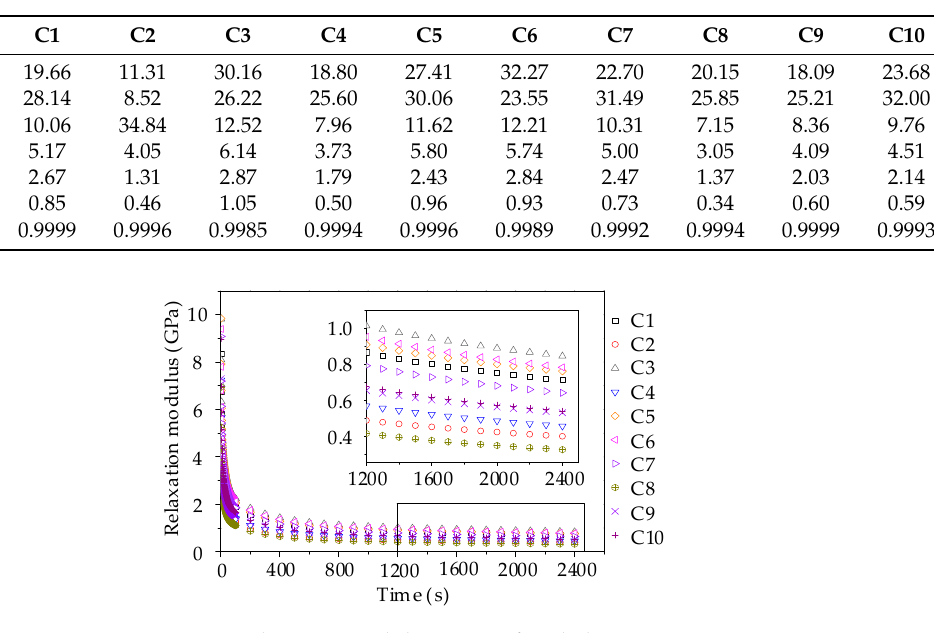
Figure 20. Relaxation modulus curve of asphalt mixtures.